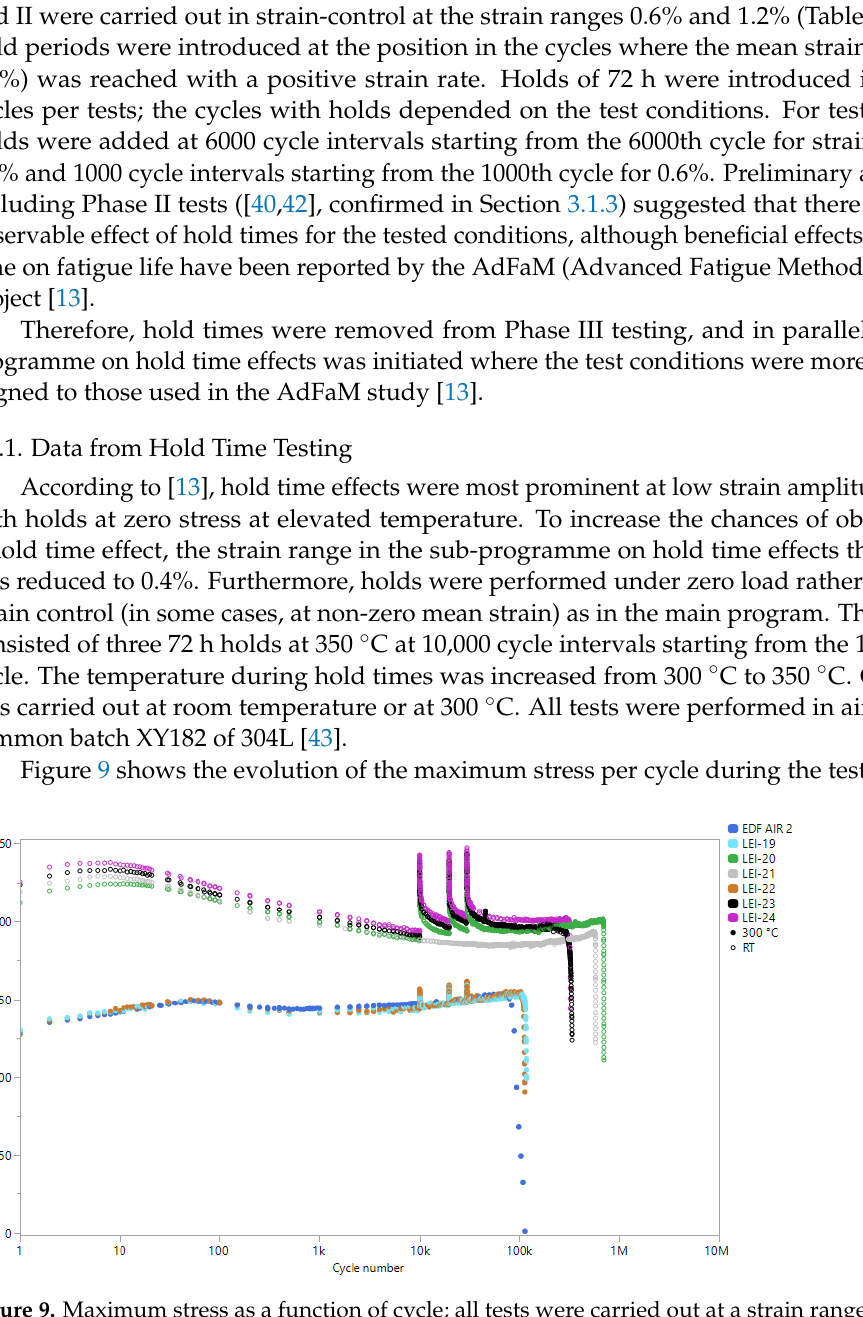
Figure 9. Maximum stress as a function of cycle; all tests were carried out at a strain range of 0.4%. The tests “EDF AIR 2” and “LEI-21” are the only tests that did not have